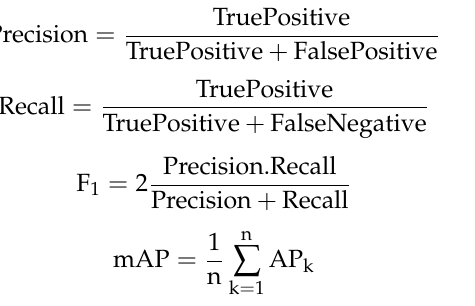
Figure 2. Deep Sort Algorithm.